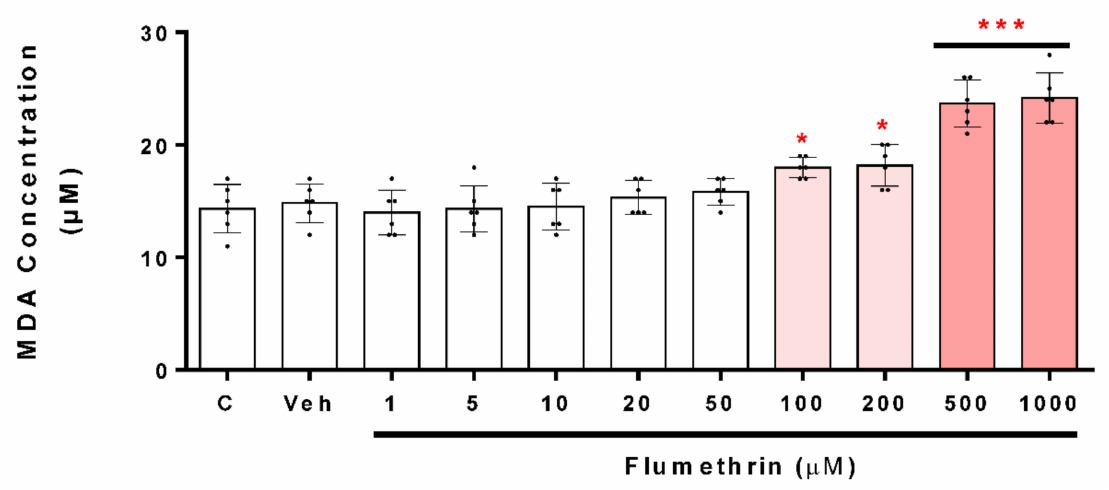
Figure 4. The MDA production induced by flumethrin (1–1000 µ M) in SH-SY5Y cells after a 24 h incubation period. The content of MDA ( µ M) was calculated for each sample from a standard curve. DMEM-treated cells with 1% FBS were the positive control (c), and cells with 0.1% DMSO were the negative control (Veh). Results are presented as the mean ± SD of six replicates. * p < 0.05, *** p < 0.001 compared to